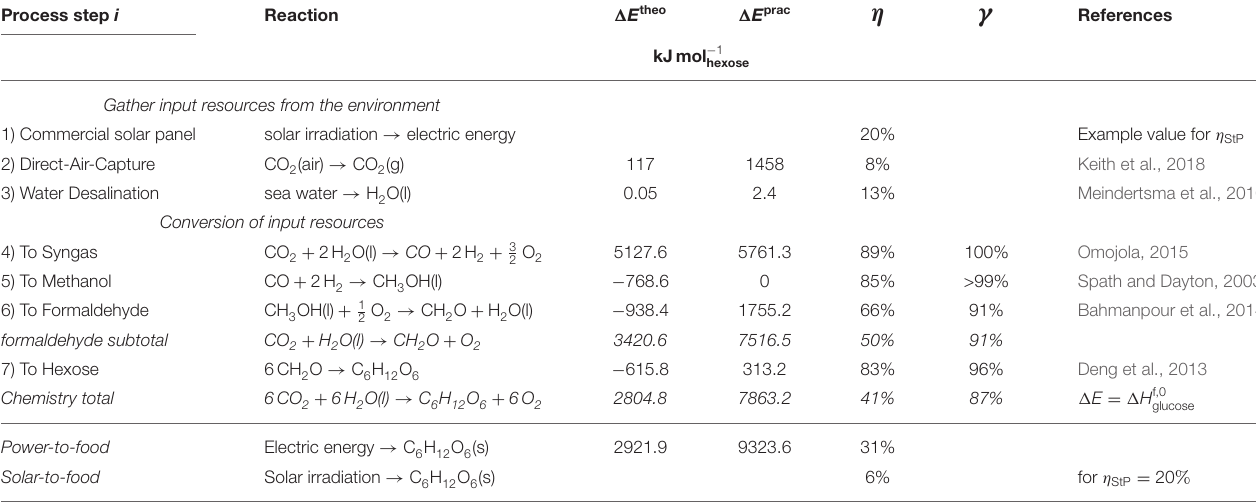
TABLE 1 | Process steps of the total synthesis of hexose from solar power. Process step